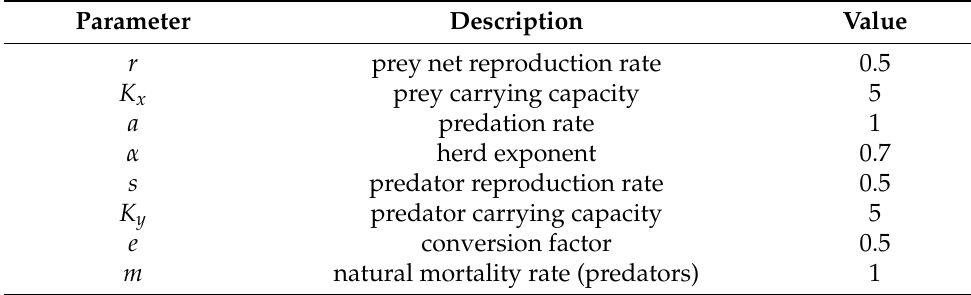
Table 7. Nominal set of parameter values for the model in (18) and (19).